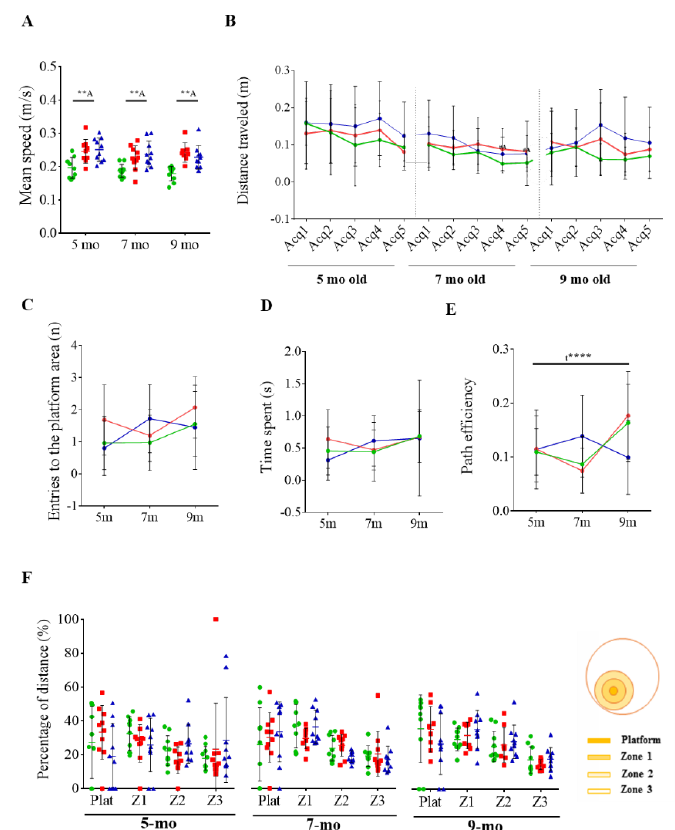
Figure 6. Reversal testing in the MWM. ( A ) Averaged swimming speed of non-transgenic (NTg, in green), triple-transgenic (3xTg-AD, in red) mice, and scFv-h3D6-treated 3xTg-AD (in blue). ( B ) Distance traveled in each acquisition stage (averaged from four trials). ( C – E ) Evolution over ages by considering ( C ) the number of entries (n), ( D ) the time spent in the platform zone (s), and ( E ) the path efficiency to the platform zone. ( F ) Percentage of distance traveled in each region (platform area, first concentric region (Z1), intermediate region (Z2), and external region (Z3)). Values are represented by means and error bands correspond to SD. # indicates a low, but not significant, p -value 0.05 < p ≤ 0.1 (Distance travelled (m), 7-month, Acq 4, NTg vs. 3xTg-AD-PBS, t = 2.001, p = 0.0607; Distance travelled (m), 7-month, Acq 5, NTg vs. 3xTg-AD-PBS, t = 1.994, p = 0.0615). * significant differences p ≤ 0.05, ** p ≤ 0.01 A refers to NTg mice.